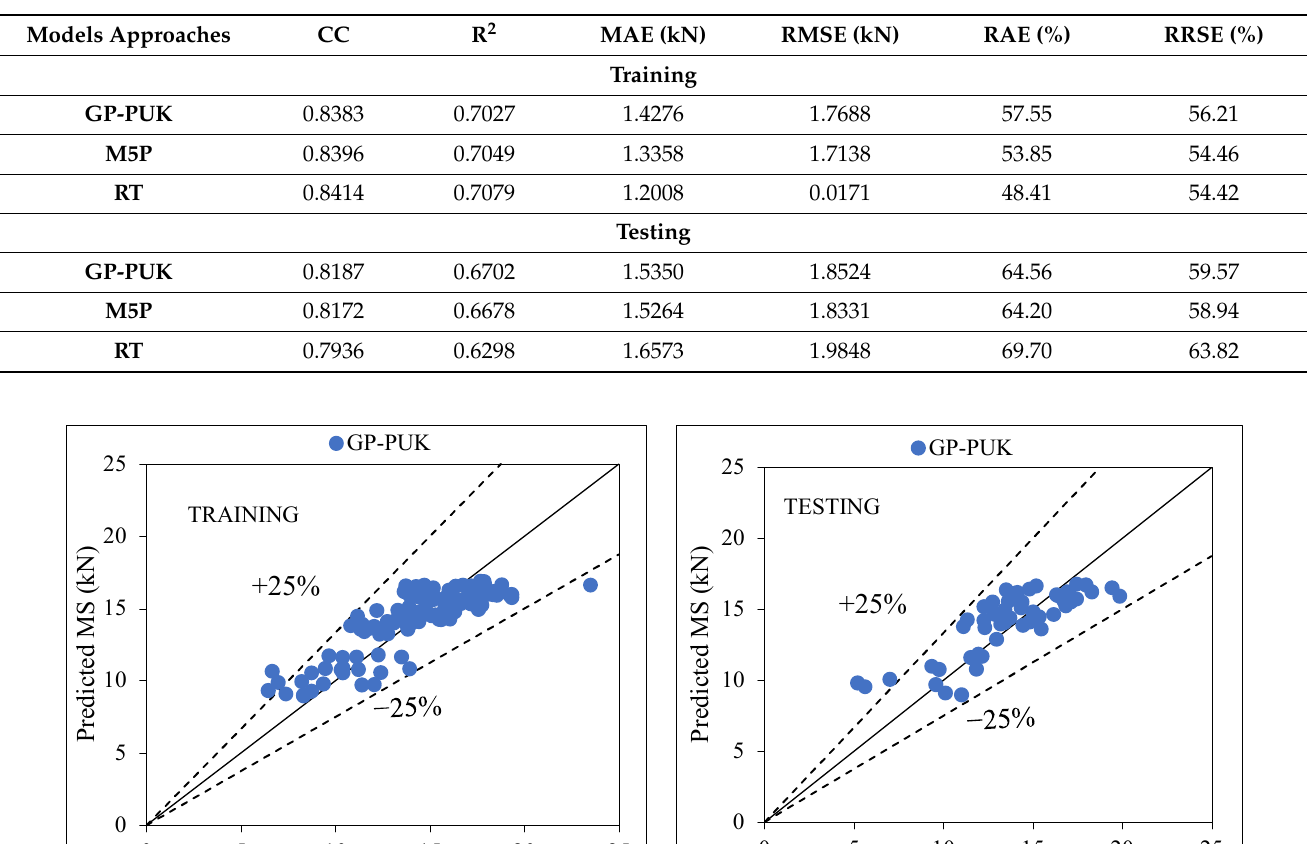
Figure 5. ( a , b ). Agreement graph showing actual vs. predicted values of MS using an ANN-based model for both stages. Table 11. Performance evaluation of GP, M5P and RT model.